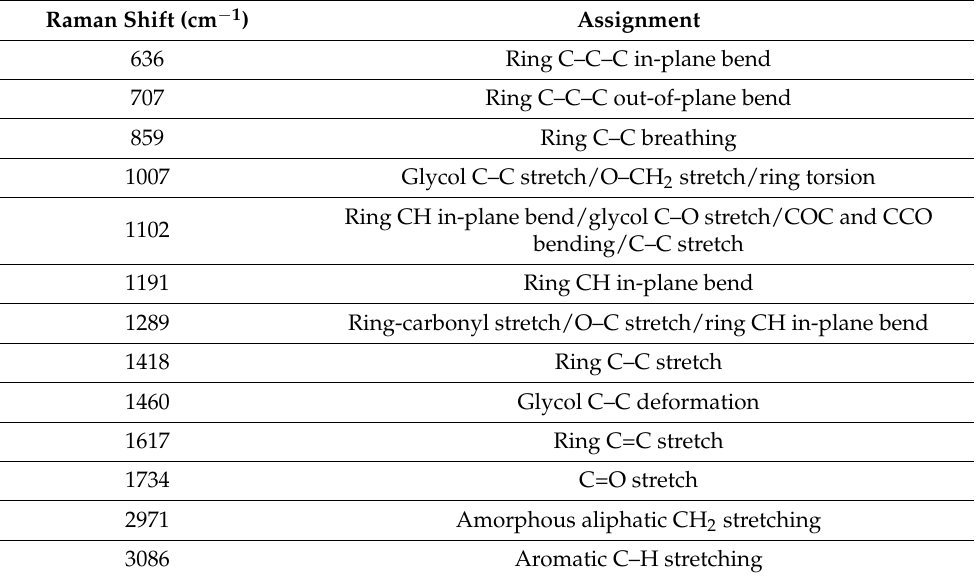
Table 1. Band assignment of the Raman spectrum for the PET substrate [20,22,23].